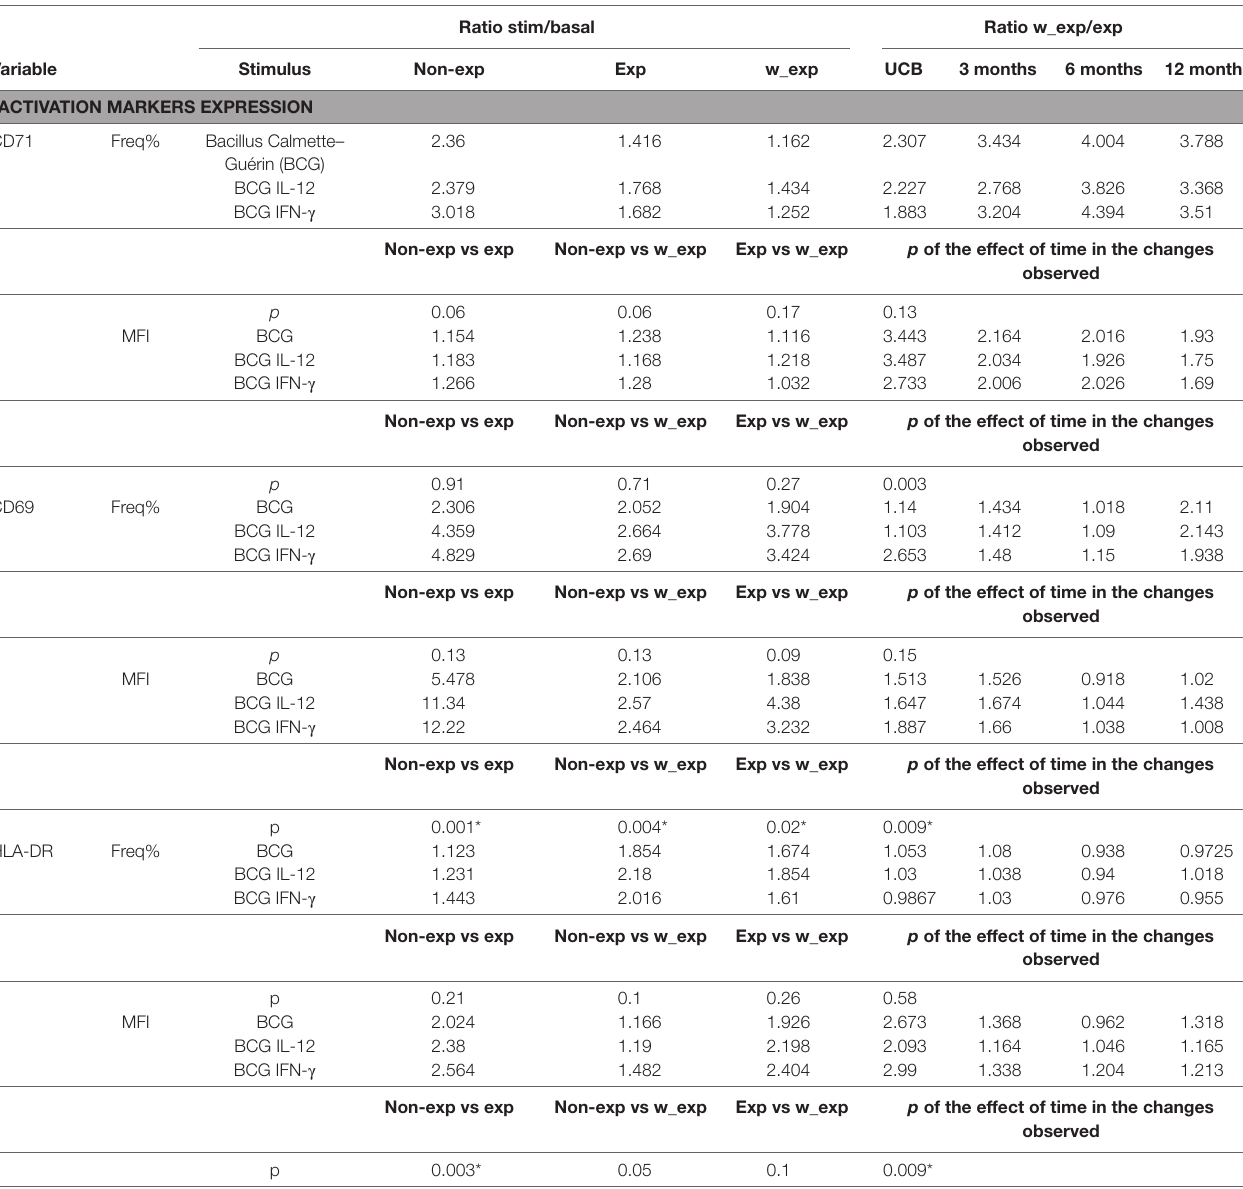
TaBle 3 | Activation markers’ expression and cytokine production after 48 h whole blood culture with different